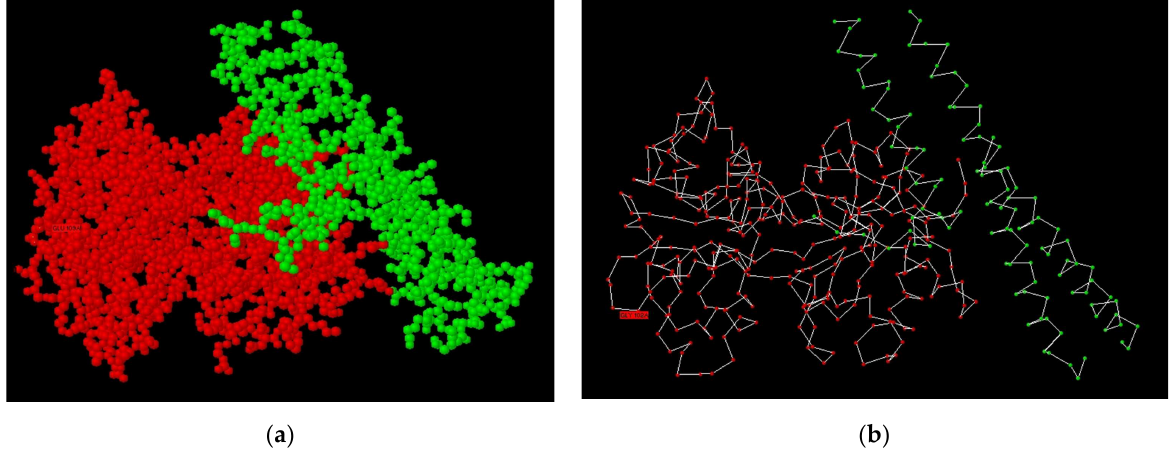
Figure 2. General view of complex of N-lobe of LF (red) with pneumococcus surface protein (PSP—green) by rendering atoms ( a ); complex of N-lobe of LF with PSP by rendering CA-skeleton ( b ).